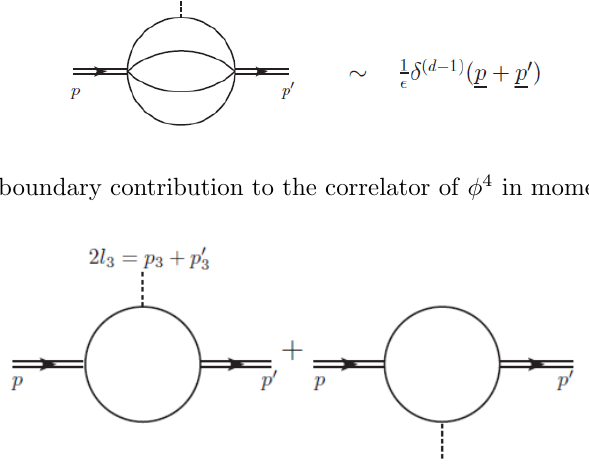
Figure 4 . The boundary contribution to the two-point function of T (cid:22)(cid:23) (inserted at the sides). planar boundary we expect some counterterms proportional to (cid:14) ( x